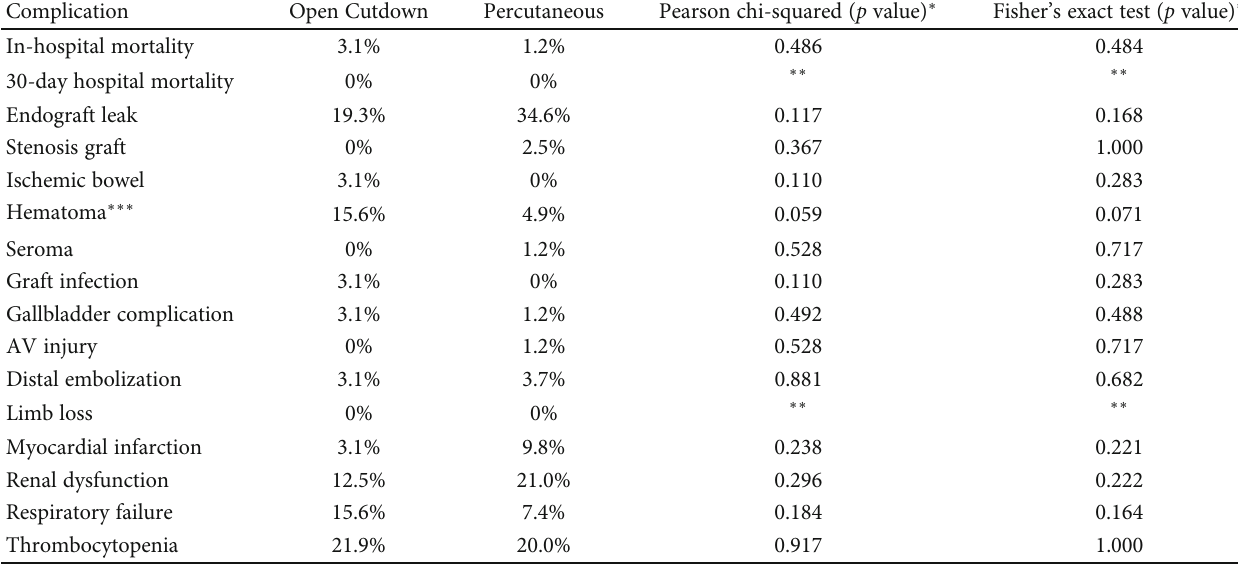
Table 1: Northside Hospital Study: retrospective EVAR vs. Open-Cutdown method and associated